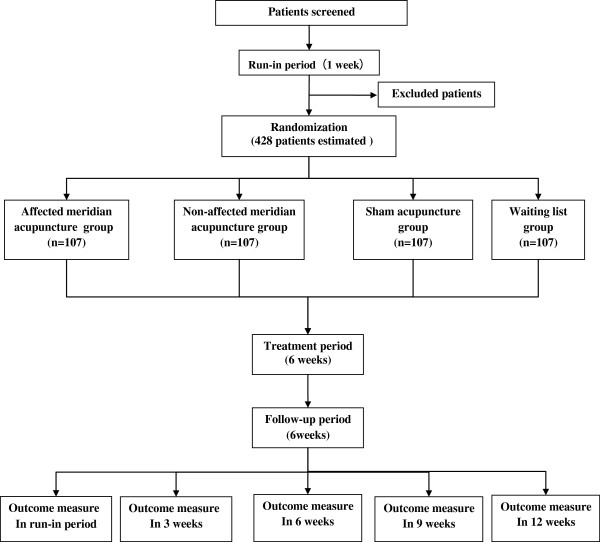
Trial flow chart.